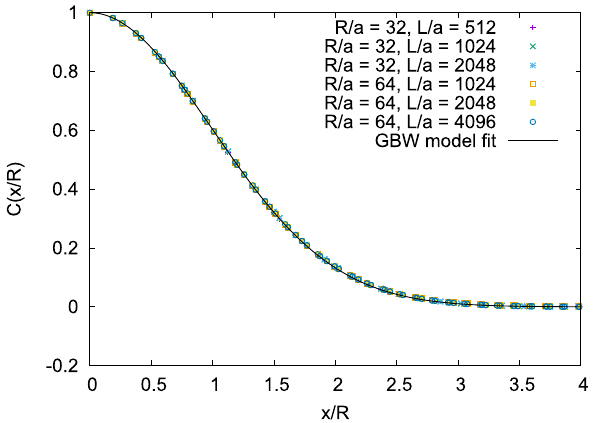
Fig. 6 Volume and lattice spacing dependence of the GBW dipole amplitude. Results from different volumes and lattice spacings fall on top of each other providing evidence of negligible finite volume and finite lattice spacing